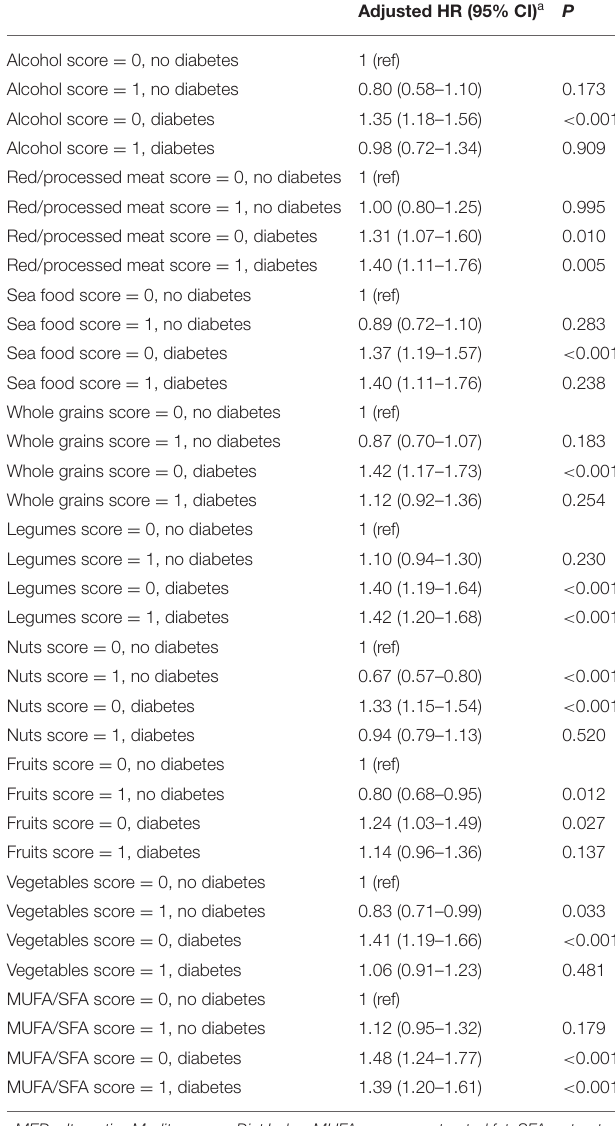
TABLE 5 | Associations of individual components of DASH score with all-cause mortality.